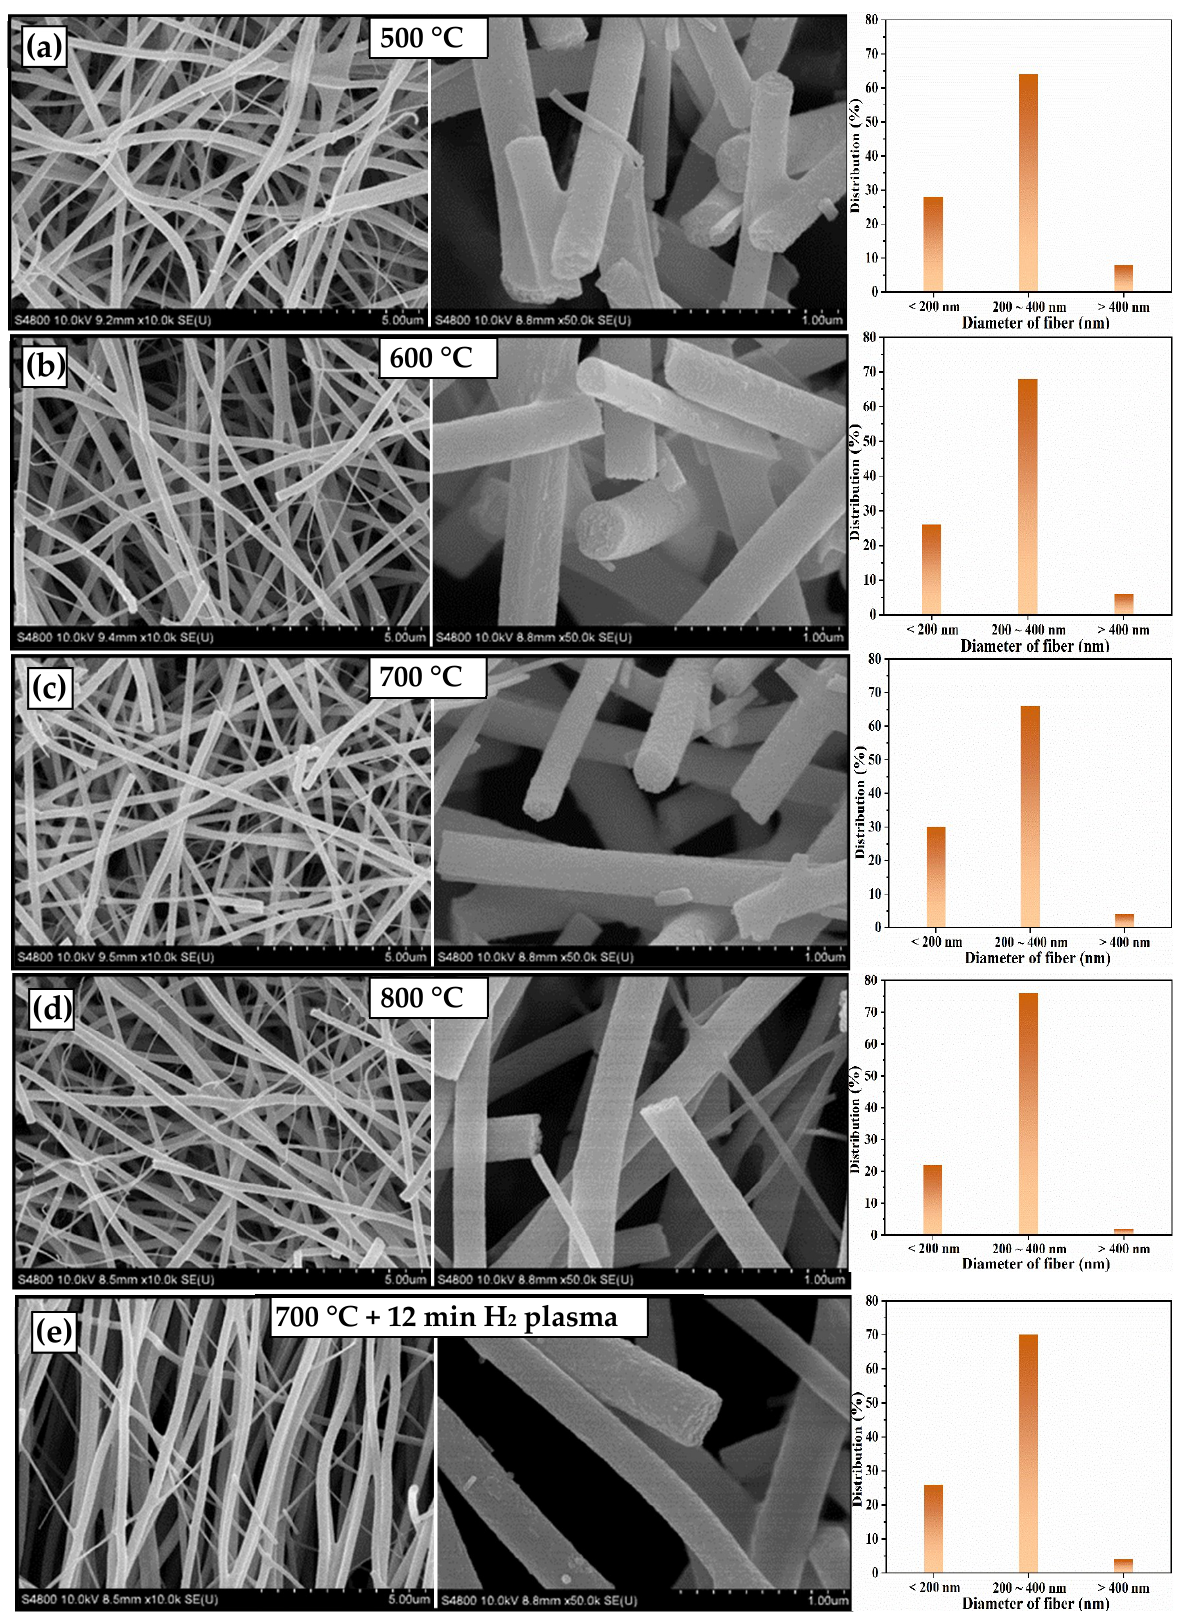
Figure 1. SEM images of TiO 2 fibers obtained after calcination at different temperatures and plasma treatments: ( a ) TiO 2 -500 °C, ( b ) TiO 2 -600 °C, ( c ) TiO 2 -700 °C, ( d ) TiO 2 -800 °C, and ( e ) TiO 2 -PH72. At the same time, BET testing was performed on the TiO 2 -700 °C, TiO 2 -800 °C, and TiO 2 -PH72 samples (in Figure 2). It was found that the specific surface area of the three samples is not different. From SEM images, it can also be observed that the TiO 2 -700 °C, TiO 2 -800 °C, and TiO 2 -PH72 samples are compact, with relatively smooth surfaces and no